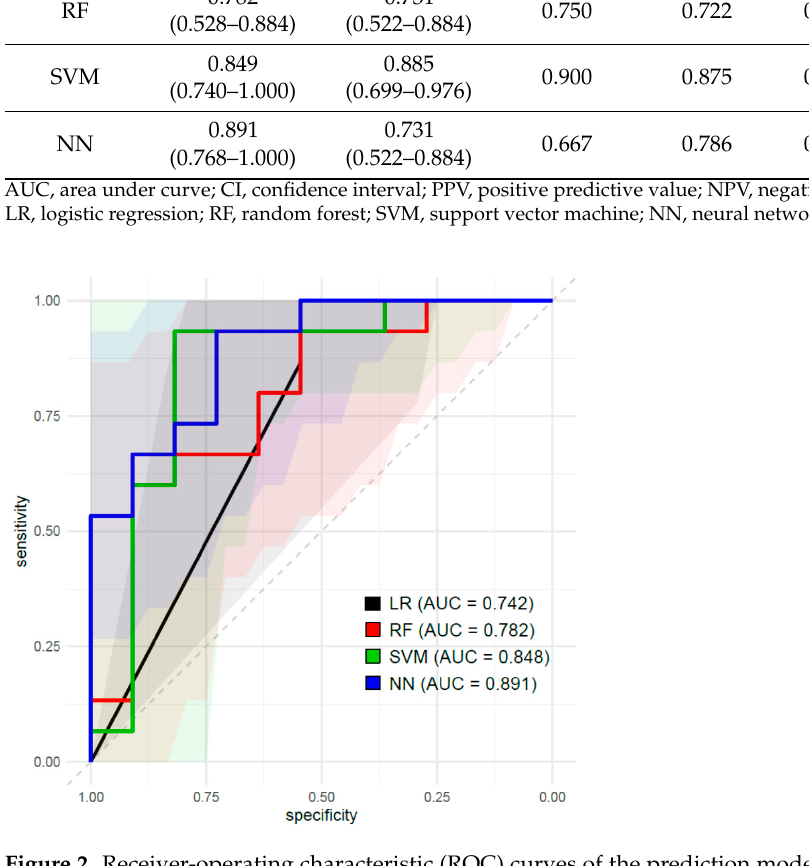
Figure 2. Receiver-operating characteristic (ROC) curves of the prediction models constructed by logistic regression (LR), random forest (RF), support vector machine (SVM), and neural network (NN) algorithms using MRI radiomic features in the test dataset.